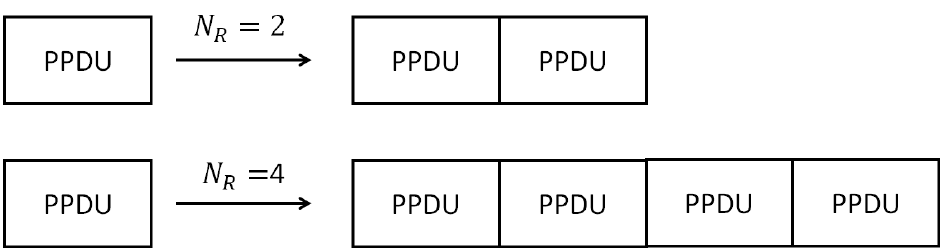
Figure 2. SmartBAN frequency spectrum.